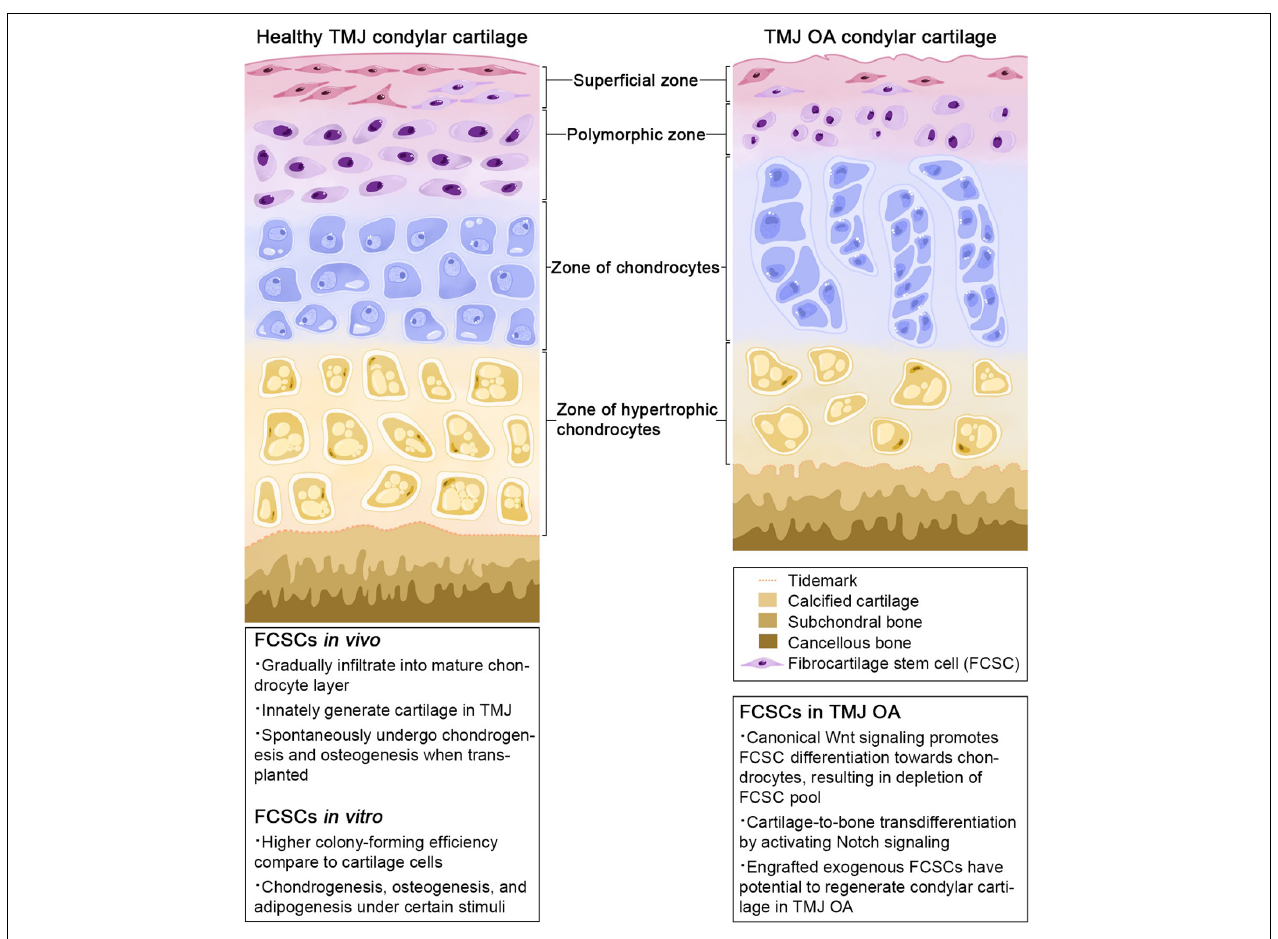
FIGURE 1 | Zonal structure of TMJ condylar